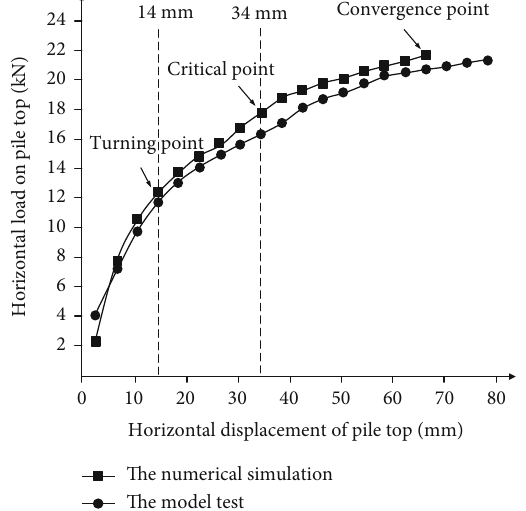
Figure 17: Displacement-load relation diagram of pile top.